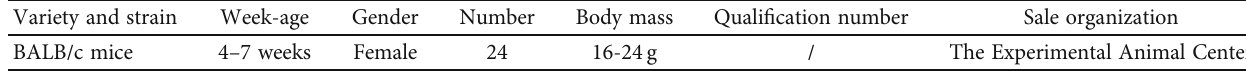
Table 1: Relevant information about experimental animals.